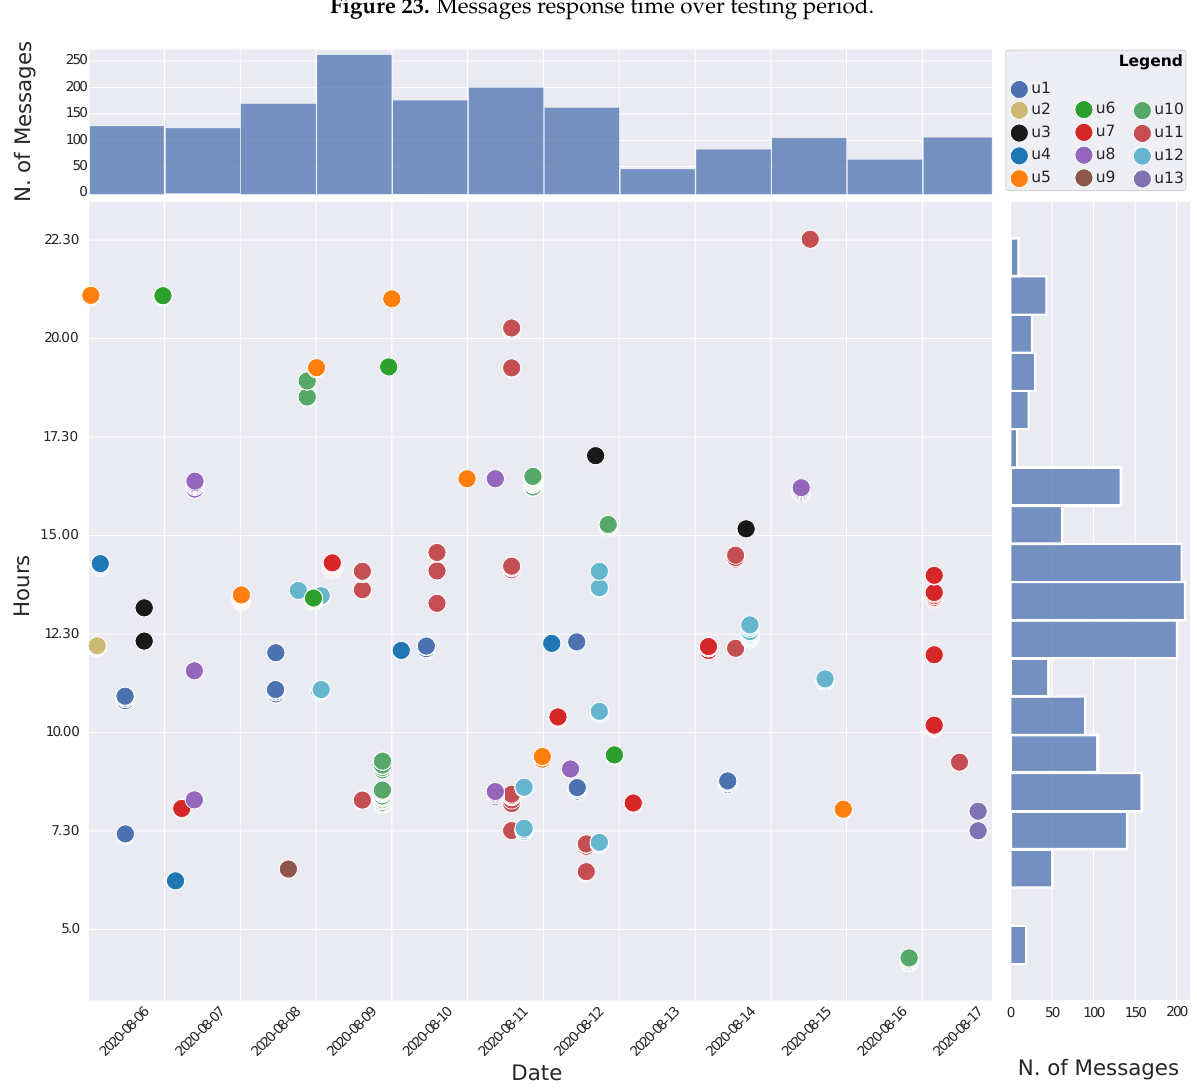
Figure 24. Overall users interaction with EREBOTS over the testing